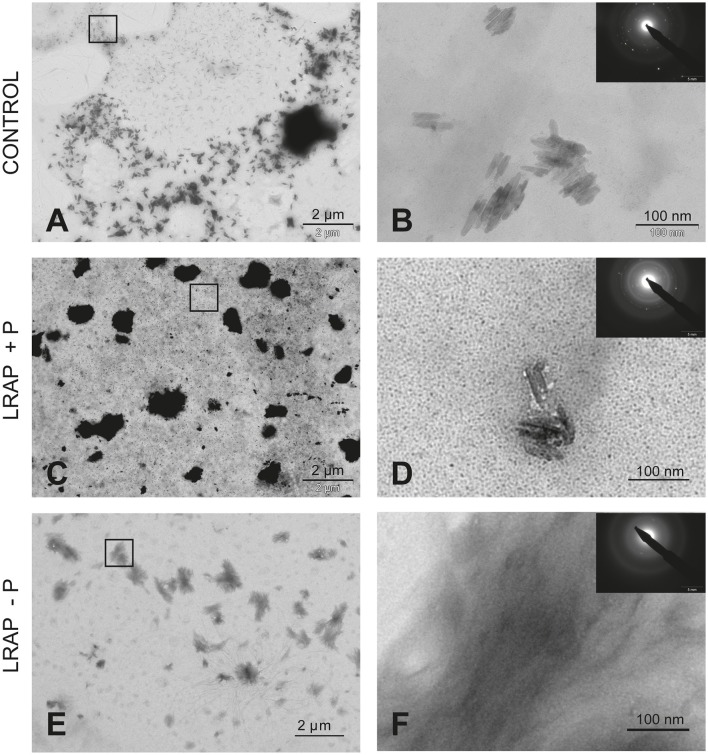
TEM and SAED analyses of mineral phases formed under mineralizing conditions by the LS8 cells in the absence and presence of added peptide. (A,B) CONTROL, no added peptide; (C,D) LRAP(+P); and (E,F) LRAP(–P). In (A,C,E), general crystal distribution can be observed, crystal characterization is presented in (B,D,F). As shown, ordered needle like HAP (based on the observed selected area diffraction patterns) crystals were formed in the control (A,B) and in the presence of LRAP(+P) (C,D) in the LS8 cells. In the presence of LRAP(–P), the HAP crystals (SAED pattern in inset) appeared thinner, longer, and grouped in bundles (E,F).